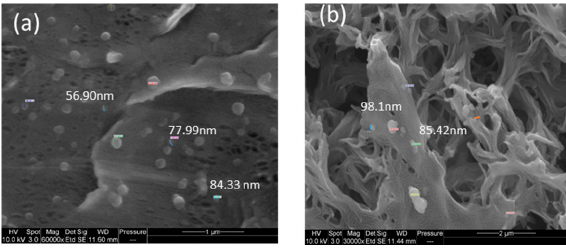
Figure 7. Images showing the presence of GO nanosheets: ( a ) M8 top surface (Magnification: 60,000×) and ( b ) M10 top surface (Magnification: 30,000×).